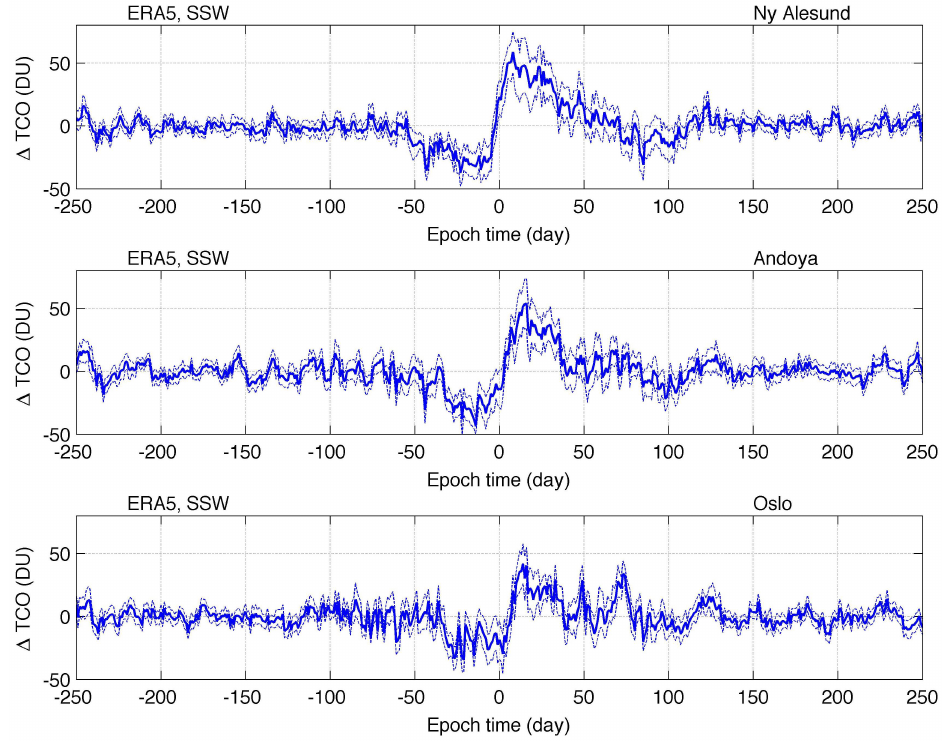
Figure 6. ERA5: Composite of 15 major SSWs at Ny Ålesund, Andøya and Oslo. The dashed lines show the mean error of the